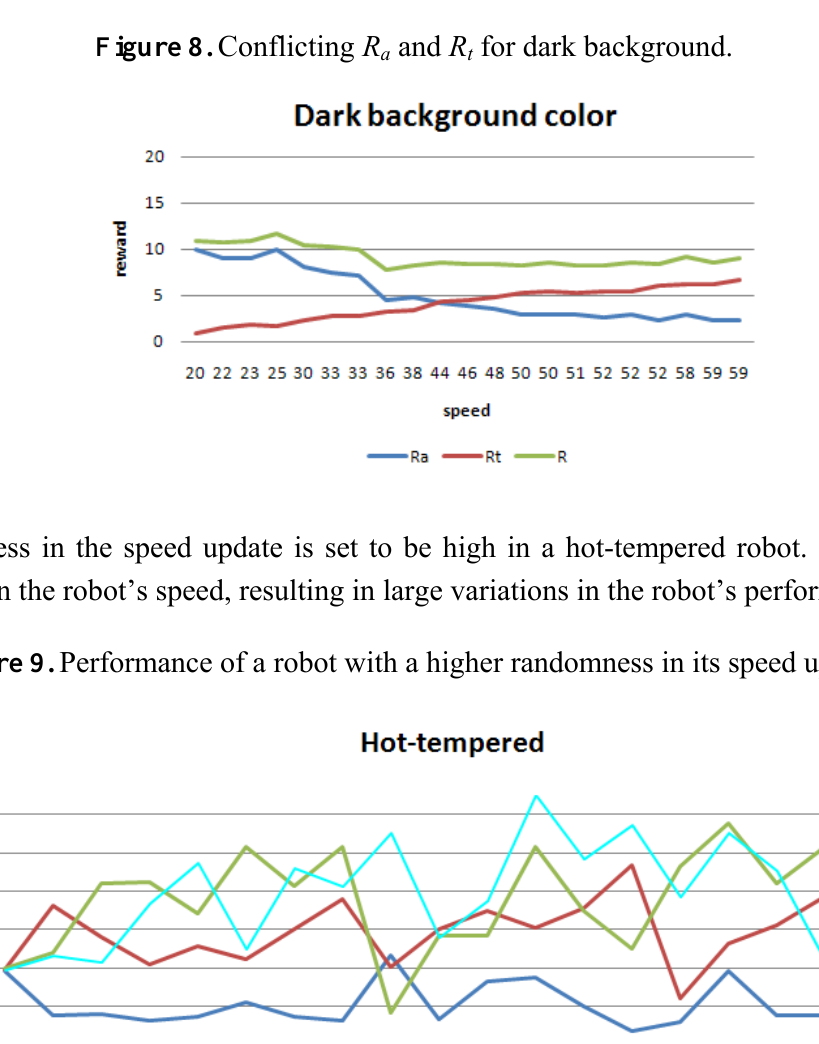
Figure 8. Conflicting R